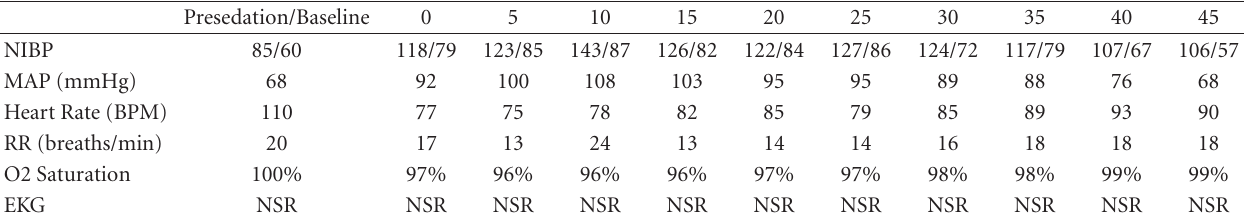
Table 1: Vital Signs at time points (minutes) prior to, during, and following initiation of the dexmedetomidine bolus and infusion.